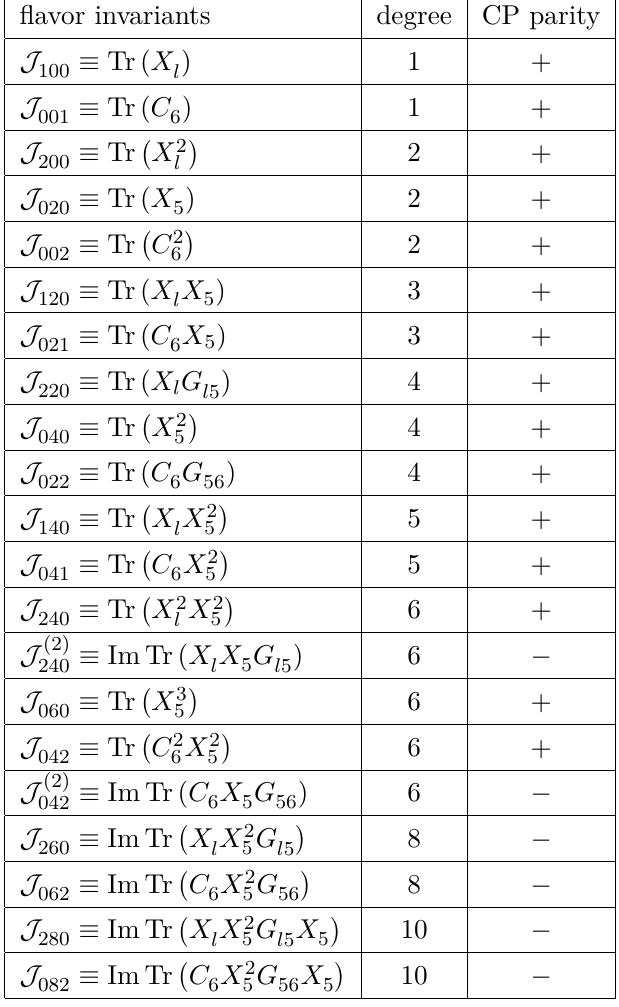
Table 2 . Summary of the primary flavor invariants along with their degrees and CP parities in the SEFT for three-generation leptons, where the subscripts of the invariants denote the degrees of X , C and C , respectively. We have also defined X ≡ Y Y † 5 6 l l l . There are in total 21 primary invariants in the invariant ring of the flavor space G ≡ C C ∗ C † 56 5 6 5 and 6 of them are CP-odd, corresponding to the 6 independent phases in the three-generation